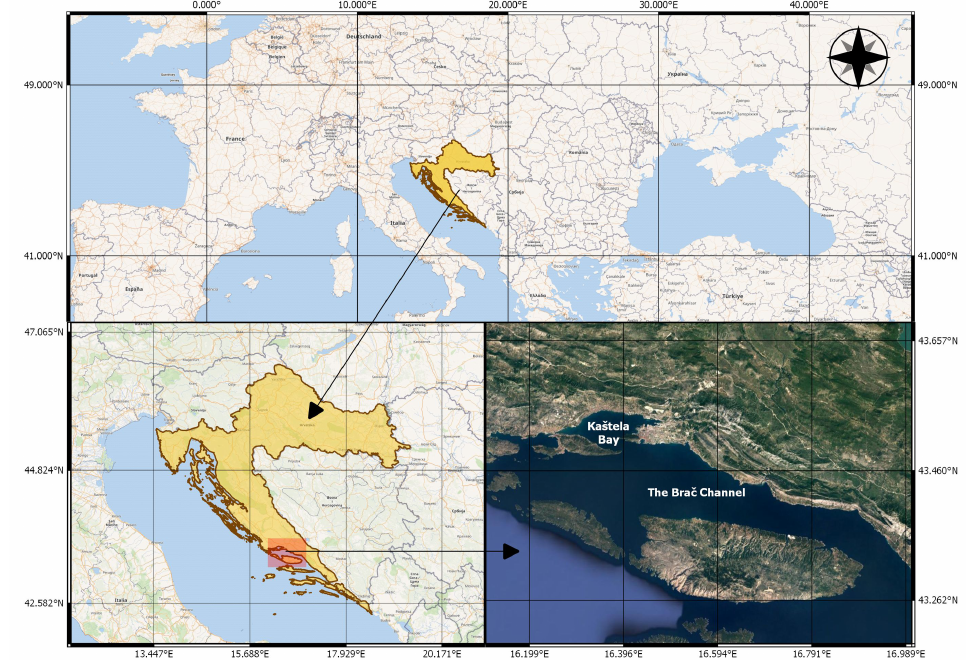
Figure 1. Map of the geographical location of the study area (Kaštela Bay and The Braˇc Channel) in the context of Europe and the Republic of